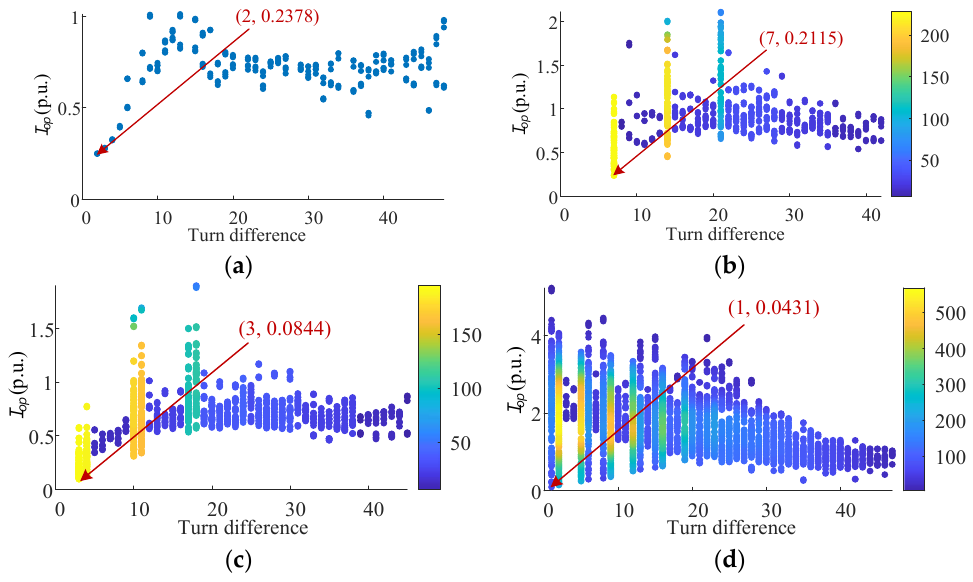
Figure 12. When s = − 0.05, the simulation results of all possible internal short ‐ circuit faults in rotor windings: ( a ) in ‐ slot faults; ( b ) end faults in the same branch with different short turns; ( c ) end faults between two branches in the same phase; ( d ) end faults between phases.